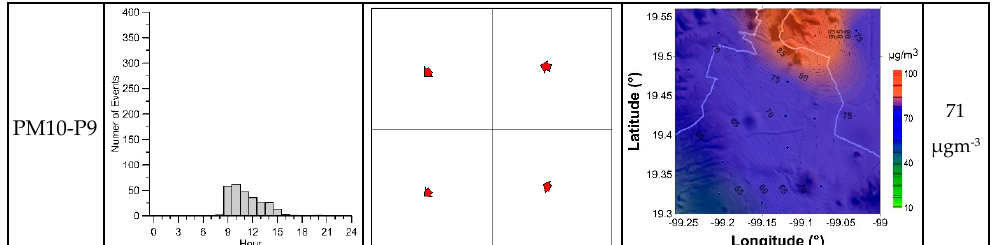
Figure 11. Flow patterns of PM 10 in the Mexico City region during the period 2001–2010. For each flow pattern, the figures show the hourly population (second column), the mean flow vectors (relative to the pattern) at the city quadrants (third column), the surface concentration distributions (fourth column) averaged over the events of the flow pattern, and the mean spatial concentration (last column). The size of red arrows that stand in for the PM 10 flow vectors indicates the flow intensity in a scale relative to the edge size of the squares that represent the quadrants.